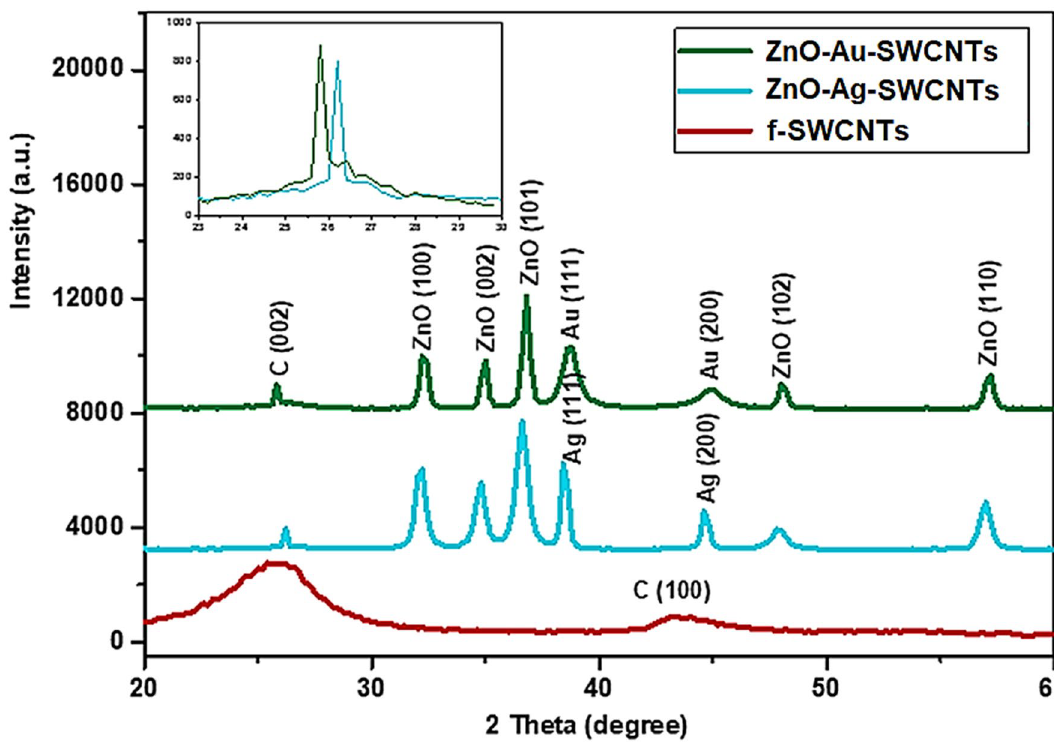
Figure 1. XRD pattern of the ZnO–Au-SWCNTs, ZnO–Ag-SWCNTs, and f